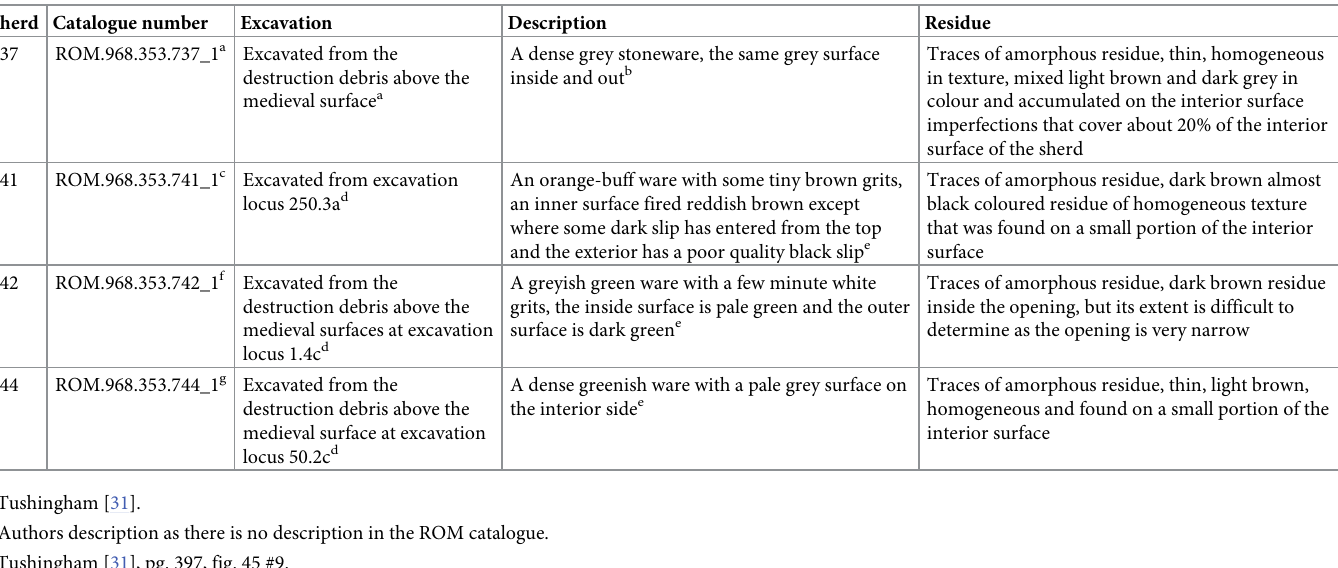
Table 3. The details and description of each sherd and